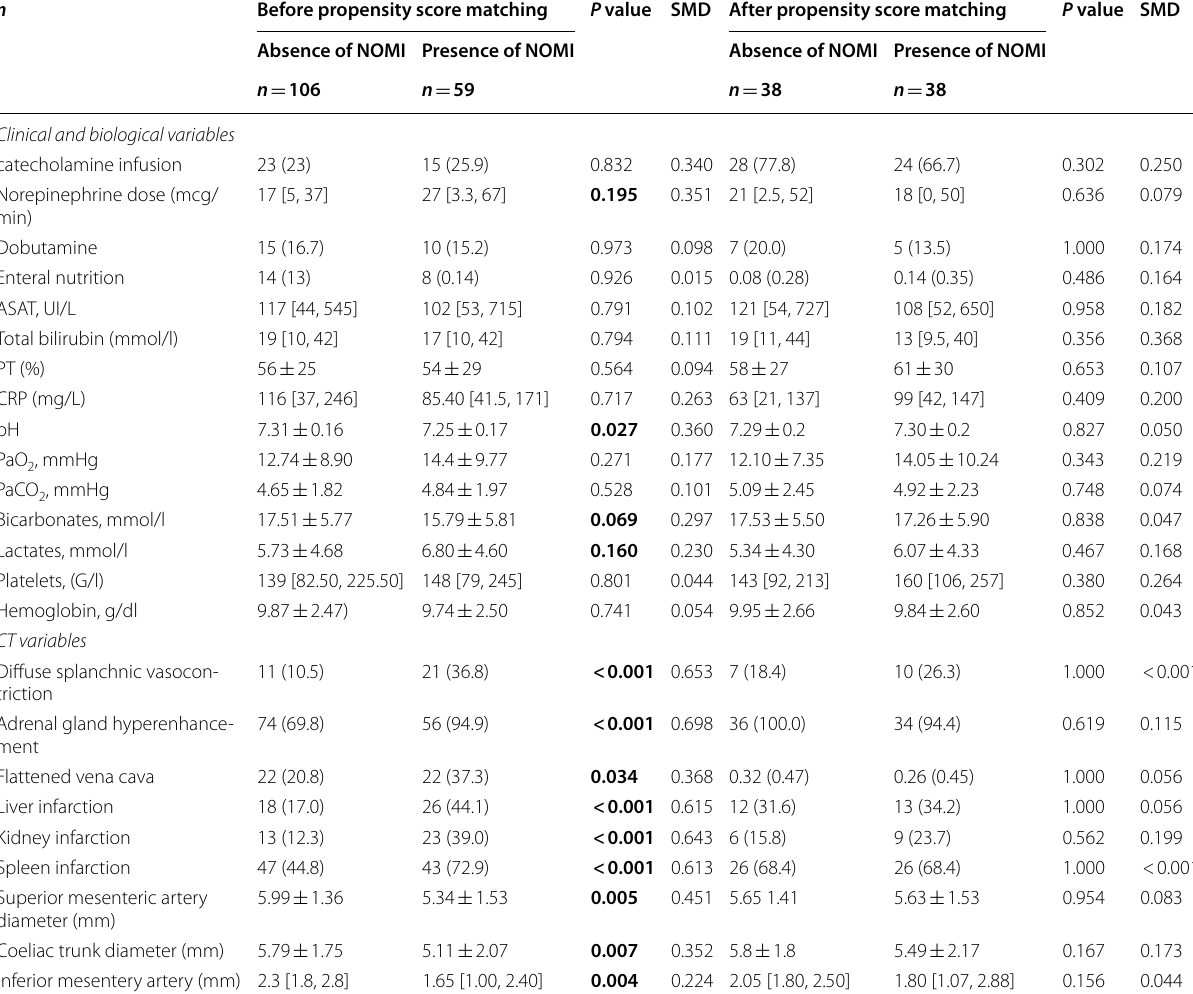
Numbers in brackets are percentages for qualitative variables Non-normal quantitative variables are expressed as median and interquartile range and compared using Wilcoxon-Test Normal quantitative variables are expressed as mean standard deviation and compared using student test ± Bold value are variables included in the propensity matched analysis CT computerized tomography, NOMI nonocclusive mesenteric ischemia, ASAT aspartate aminotransferase, PaCO 2 arterial blood carbon dioxide tension, PaO 2 arterial blood oxygen tension, SD standard deviation, PT prothrombin rate, SMD Standard mean